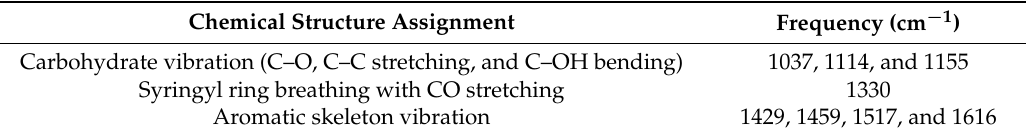
Figure 6. Infrared spectra of the WF, TSSL, TSSL-94+WF-RT, TSSL+WF-RT, and TSSL+WF-94. Table 2. Assignment of the Infrared Bands of the TSSL Sample